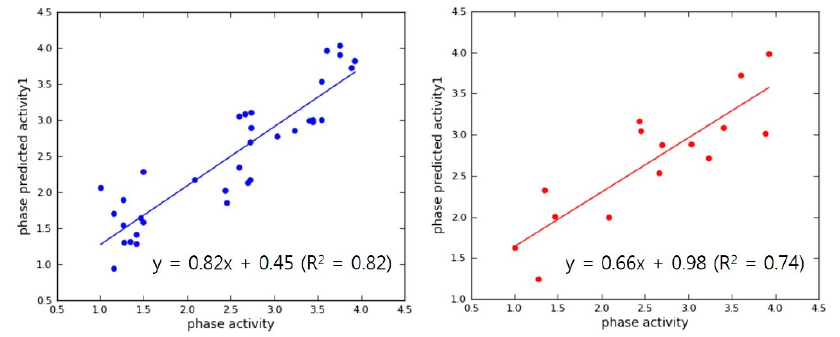
Figure 5. APRRR215 regression lines for the training (blue) and test (red) sets.